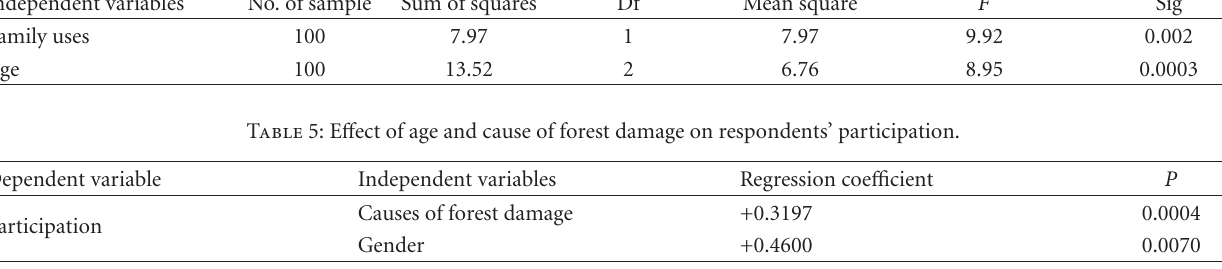
Table 6: Comparisons of means for the selected variables a ff ect the dependent variable (Participation). Independent variables No. of sample Sum of squares Df Mean square F Sig Causes of forest 100 5.01 1 5.01 damage Gender 100